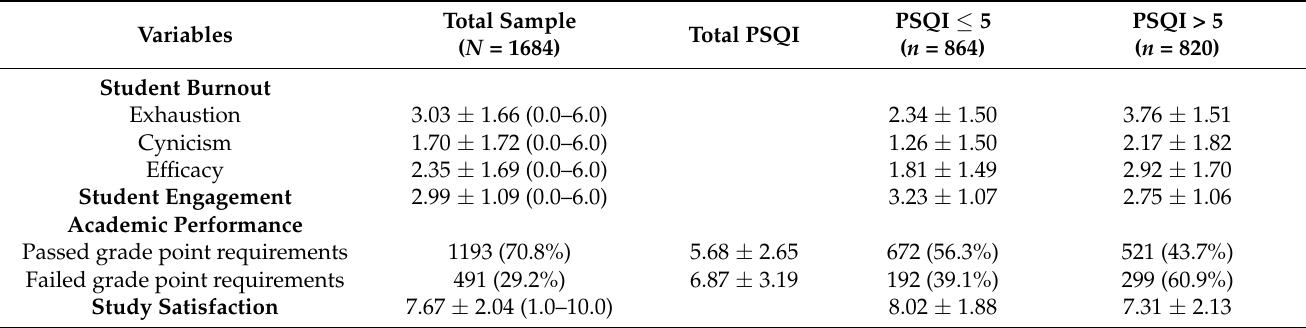
Table 3. Descriptive characteristics of study-related indicators stratified by PSQI classification.